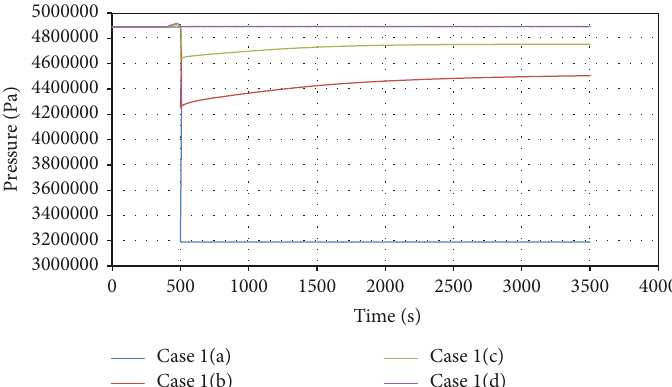
Figure 12: Average pressure in the core.